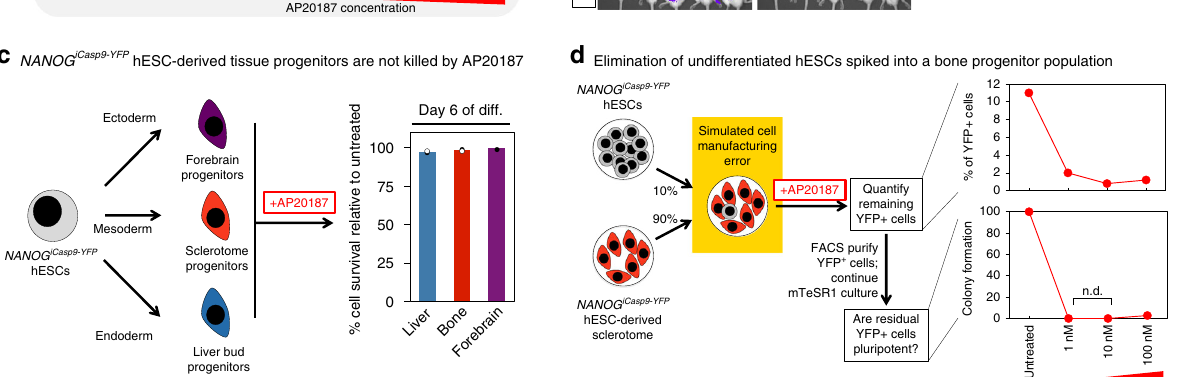
Fig. 3 Implementation of the NANOG iCasp9-YFP safety switch. a Schema depicting how drug AP20187 induces dimerization of Caspase9 in